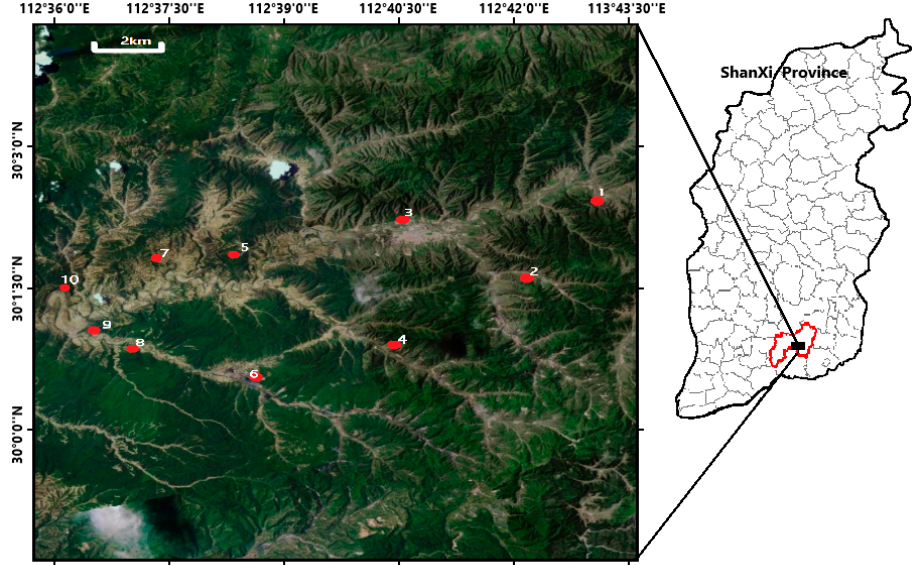
Figure 1. The 10 CBM wells sampled in this study locate in small folds developed in the southern slopes of Shizhuang (black block) in QinShui Basin (red circle).